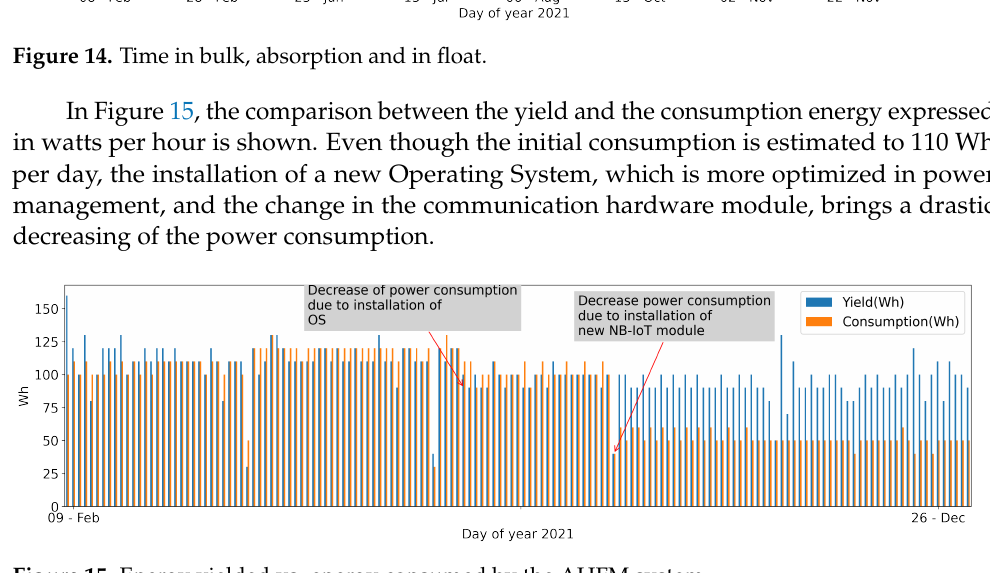
Figure 15. Energy yielded vs. energy consumed by the AHFM